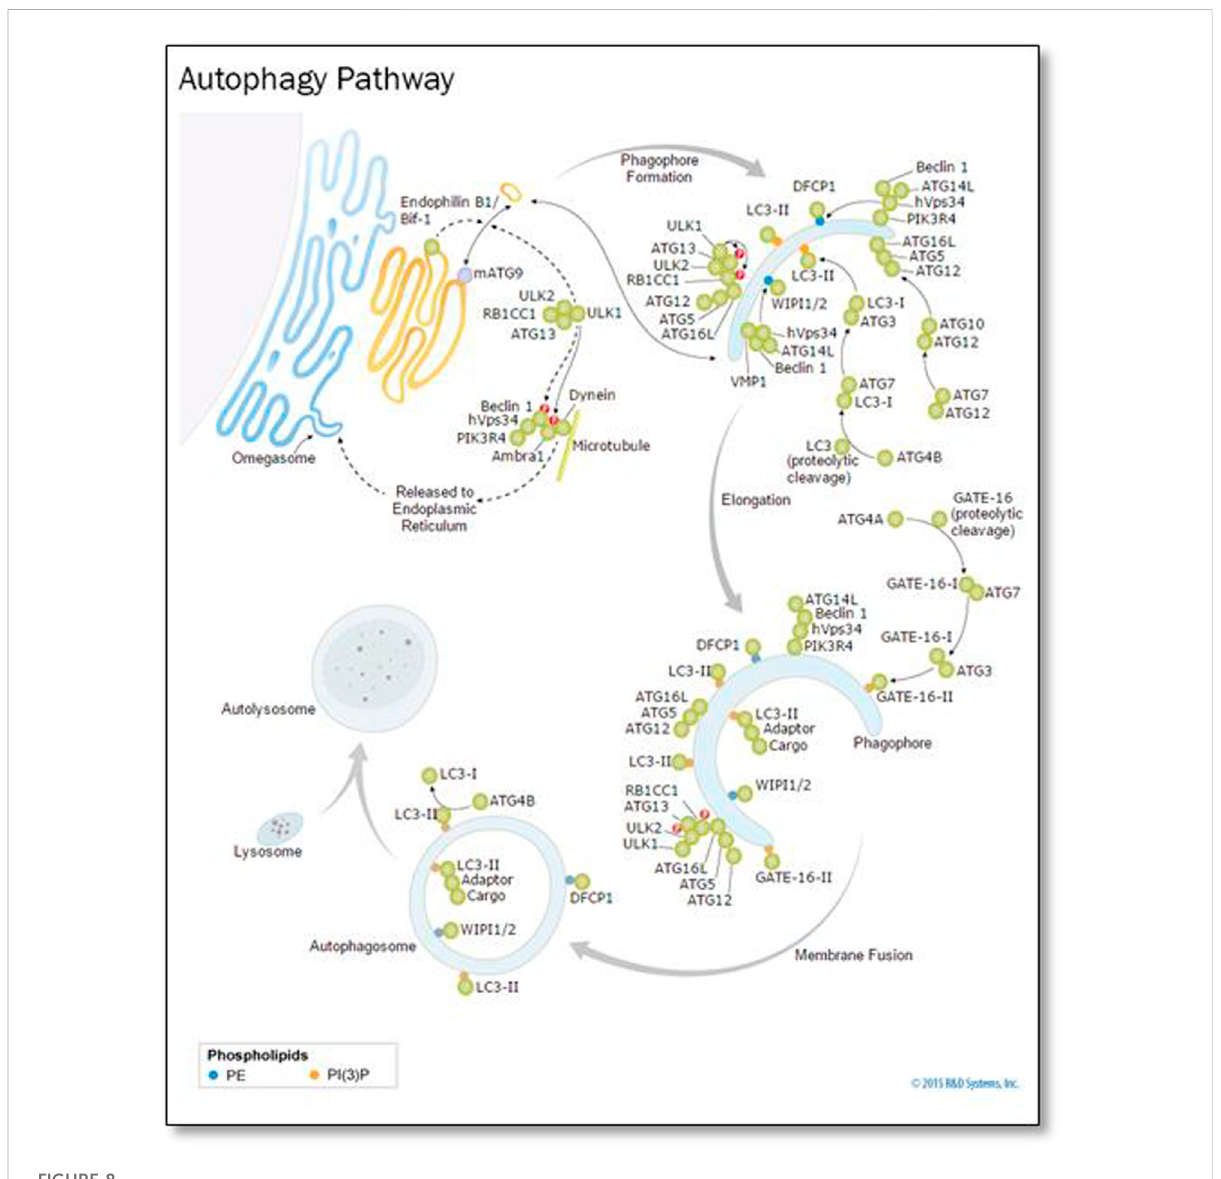
FIGURE 8 Ubiquitin, related modi fi ers, and pathways (R&D Systems Europe,